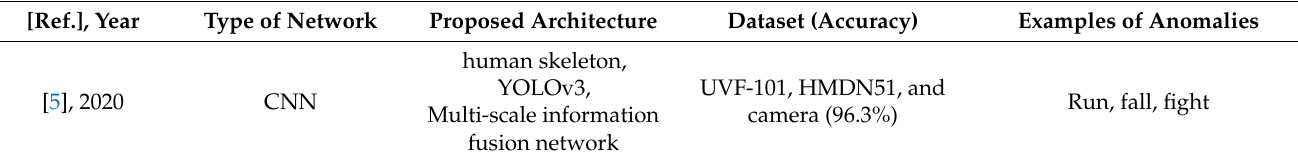
Table 1. DL approaches applied to AD for